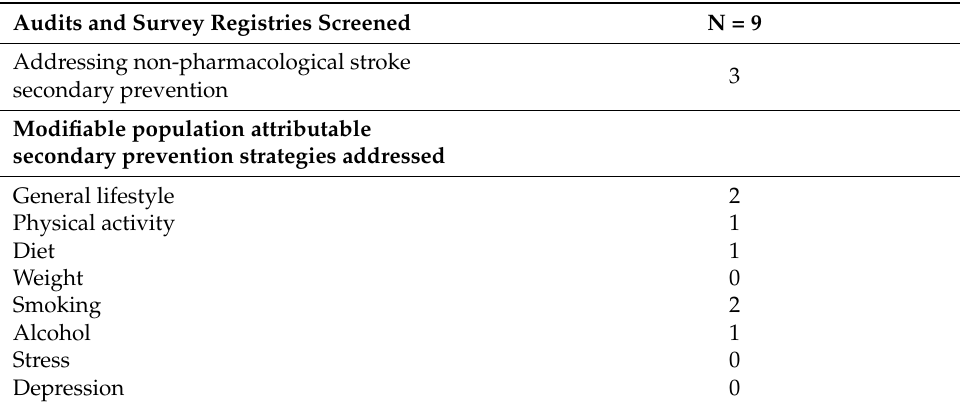
Table 4. Stroke care audits/surveys included in the